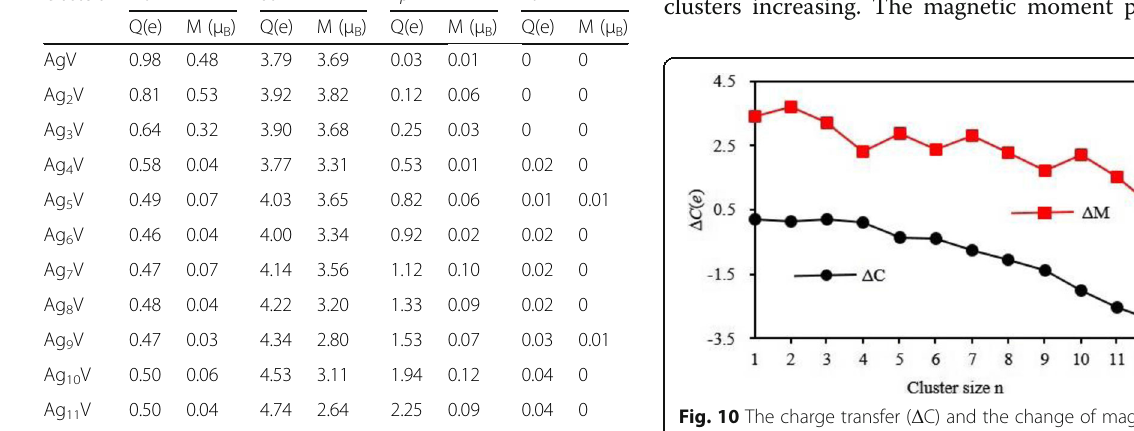
Table 5 The charge (Q) and local magnetic moment (M) of 4 s , 3 d , 4 p , and 5 d states for the V atom in the ground state Ag n V clusters Clusters 4 s – V 3 d – V